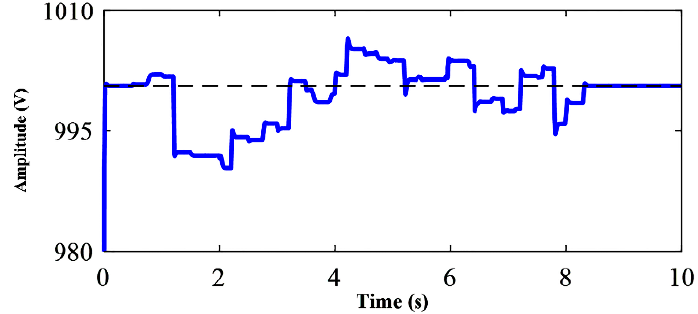
Figure 7. Capacitor bank voltage in the presence of SDRE controller.